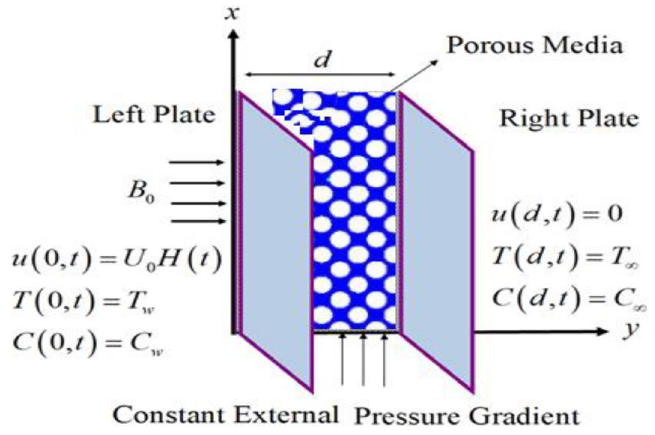
Figure 1. Geometry of the